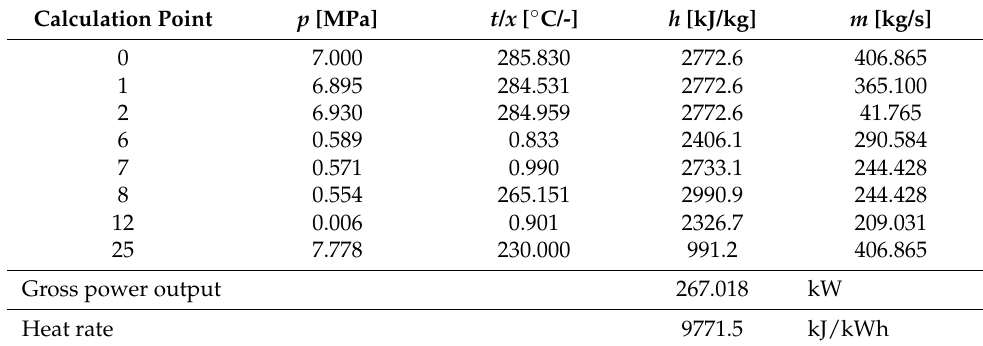
Table 4. Parameters of the steam cycle with the new HP section (Case D).